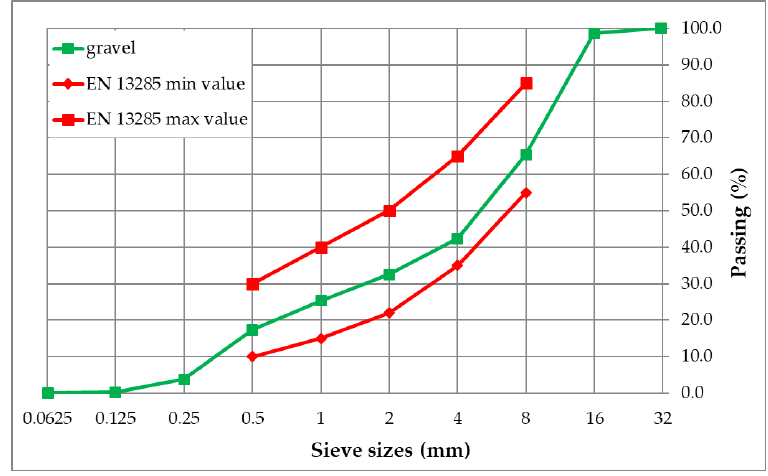
Figure 2. The grain size distribution of gravel used for the unbound base layer.